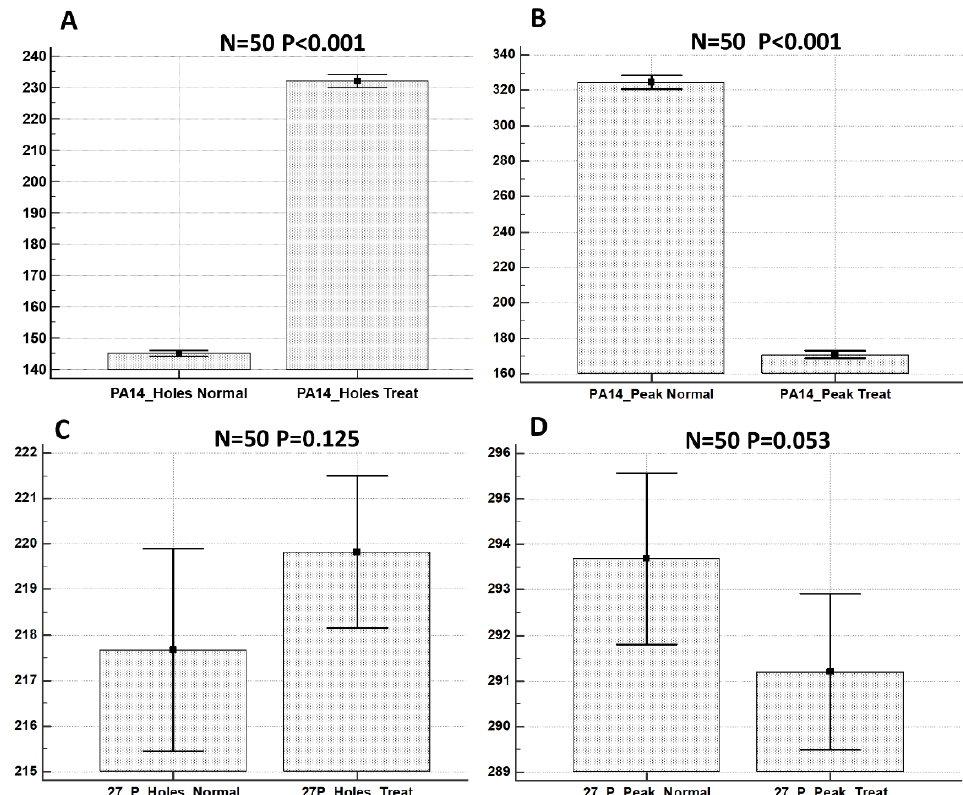
Figure 6. Statistical analysis of projected areas related to holes and peaks from: P. aeruginosa PA14 control sample ( A ); P. aeruginosa PA14 treated with KHS-Cnd ( B ); P. aeruginosa 27P control sample ( C ); and P. aeruginosa 27P treated with KHS-Cnd ( D ). N = 50 measurements were taken for each sample. Statistical difference was determined by the software MedCalc©: p < 0.05 was considered statistically significant.